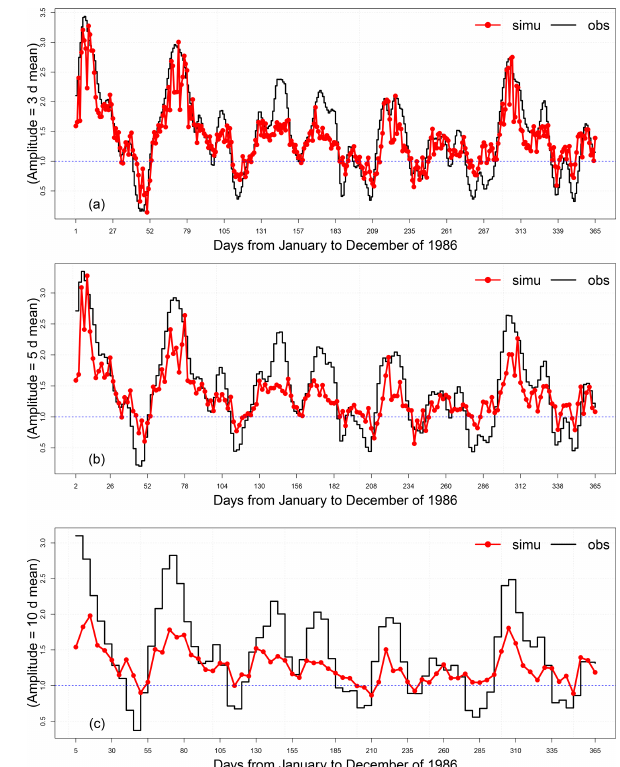
Figure 5. Time series of observations and simulations of the MJO amplitude for lead times of 3 (a) , 5 (b) , and 10d (c) for the year 1986. The red line represents the mean of the 100 simulations, the black line represents the observations, and the blue line indicates the threshold of the MJO activity (below 1: inactive; above 1: active).